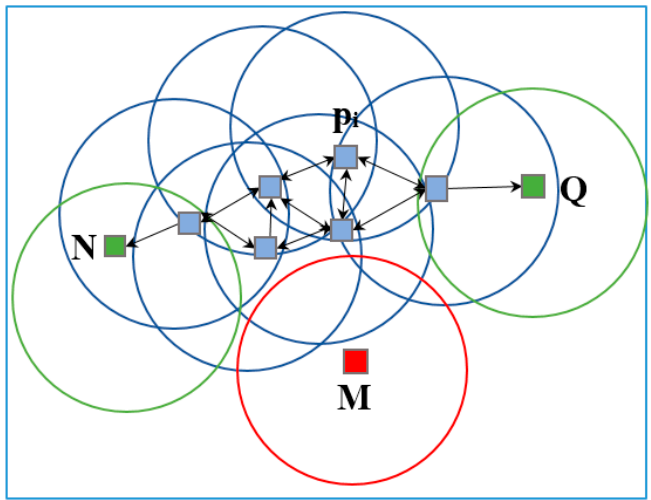
Figure 6. Principle of density ‐ based spatial clustering of applications with noise (DBSCAN).